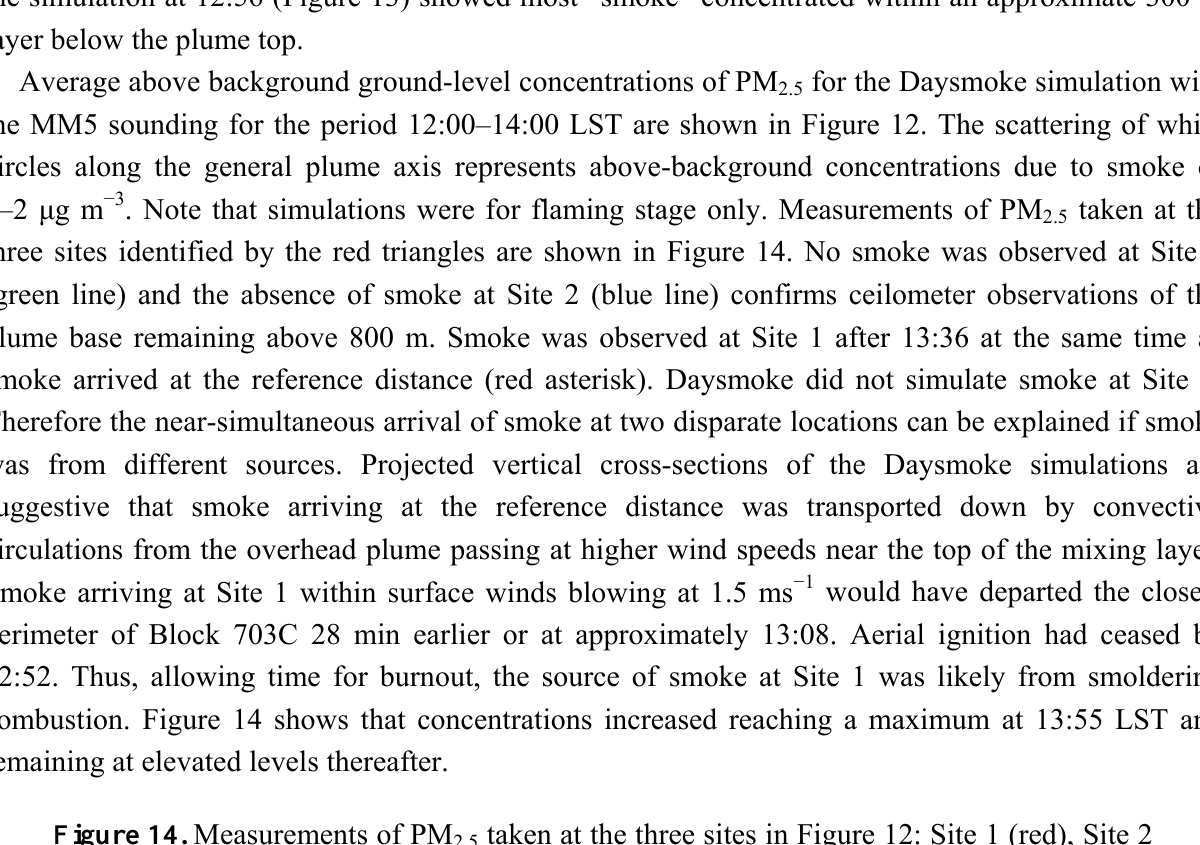
taken at the three sites in Figure 12: Site 1 (red), Site 2 2.5